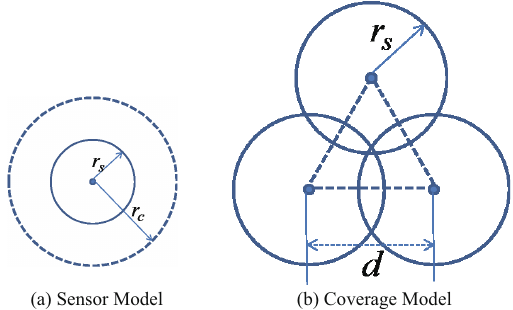
Figure 1. Both the sensing and communication ranges were assumed to be a disk, with radii of r s and r c , respectively: ( a ) sensor model; and ( b ) coverage